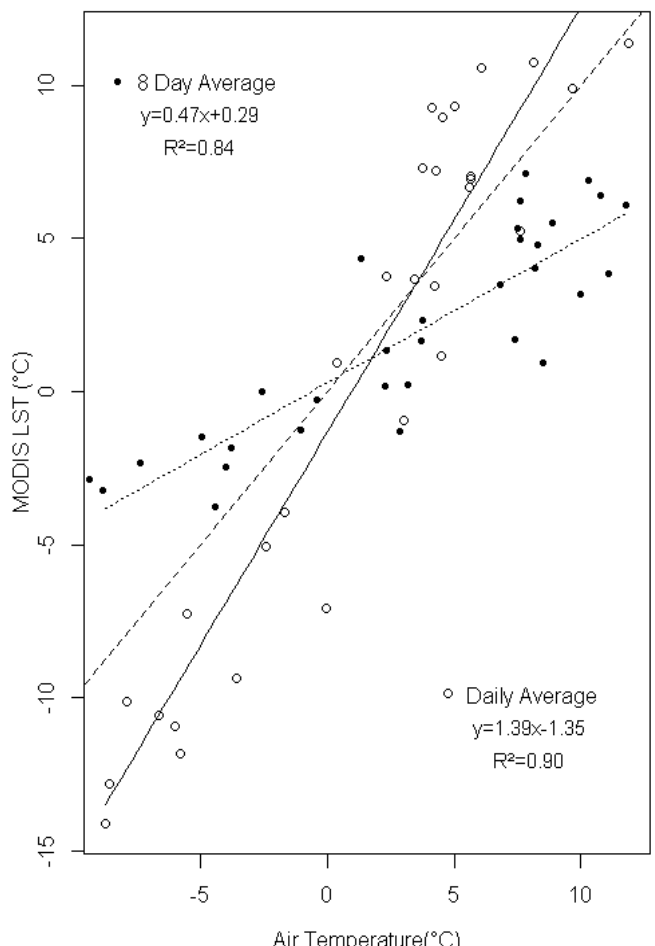
Figure 6. Daily mean Land Surface Temperature computed from maximum and minimum daily LST (MMM) compared to daily average air temperature calculated from hourly means at seven stations in the southwest Yukon (open circles and the solid line is the linear trend). The 8-day LST was computed from maximum and minimum daily values (closed circles, and the dotted line is the linear trend). The dashed line indicates the 1:1